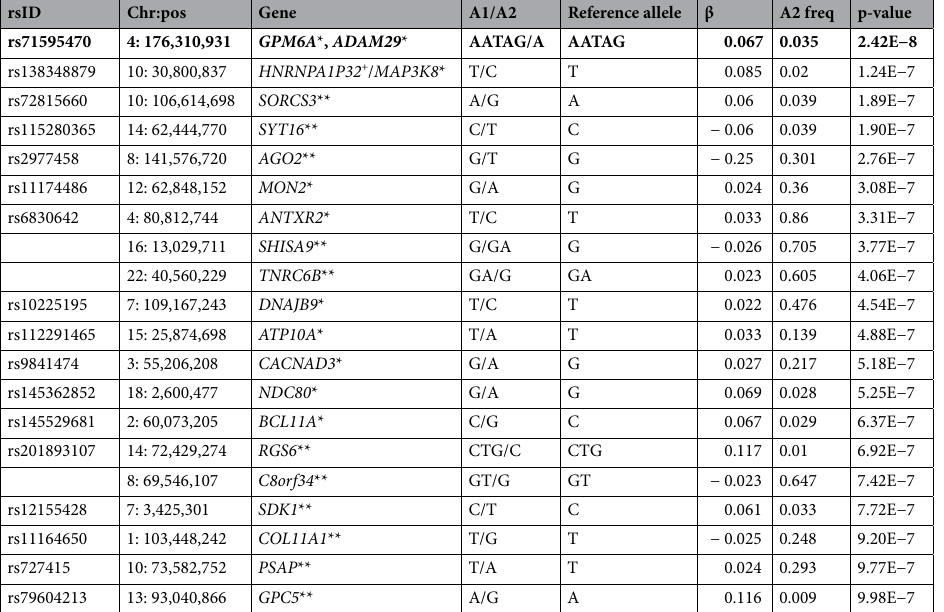
Table 3. SNPs achieving suggestive significance ( p < 10 –6 ) for tinnitus. Significant values are in bold. **Within a gene body. *Nearest gene. + Pseudogene.